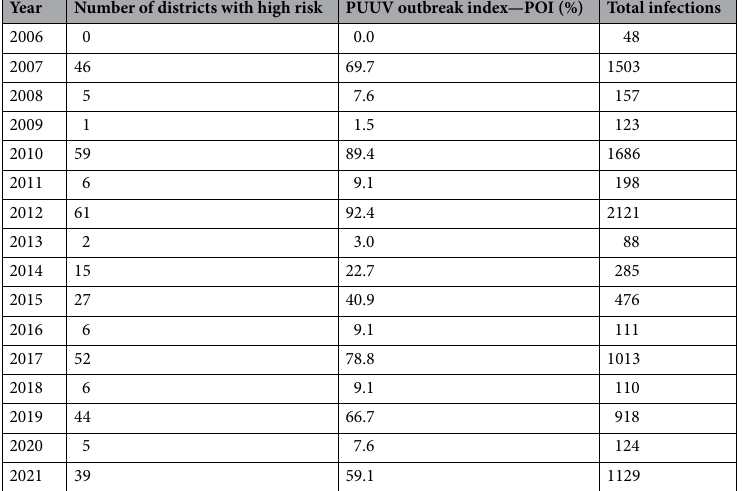
TN = 555 (53% of the total 1056 1 -score. The elements of the confusion matrix were: true negatives observations), false negatives FN = 57 (5%), false positives FP = 127 (12%), and true positives TP = 317 (30%). 5/7 classifications for high risk were correct (precision), and almost 6/7 real high-risk observations were cor- rectly classified (sensitivity). The observations in false negatives summed up to 301 infections, which was 3.5% of the infections in real high-risk observations (or 3.0% of the total infections). For the pairs (V2_SD_9, V1_ST_9) and (V2_ST_4, V1_ST_9) the two risk classes were well linearly separa- ble, with sensitivity > 77% and precision > 67% (Fig. 3a,b). Weather parameters are for the most part spatially uniform. Thus, the observations from each year formed clusters in the 3D input space of our model. The values of the weather variables for these “cluster centers” were the annual average values over whole Germany. Because of the clustering of the weather variables and the separation of the data from each year, the model classified all districts from each year in the same risk class. The only exceptions were 2006 and 2021, the years whose clusters were closest to the planar class boundary. For 2006, 58 districts were classified in the low-risk class and 8 in the high-risk class. For 2021, 40 districts were classified in the high-risk class and 26 in the low-risk class. All observations from 2007, 2010, 2012, 2015, 2017 and 2019 were classified in the high-risk class, which